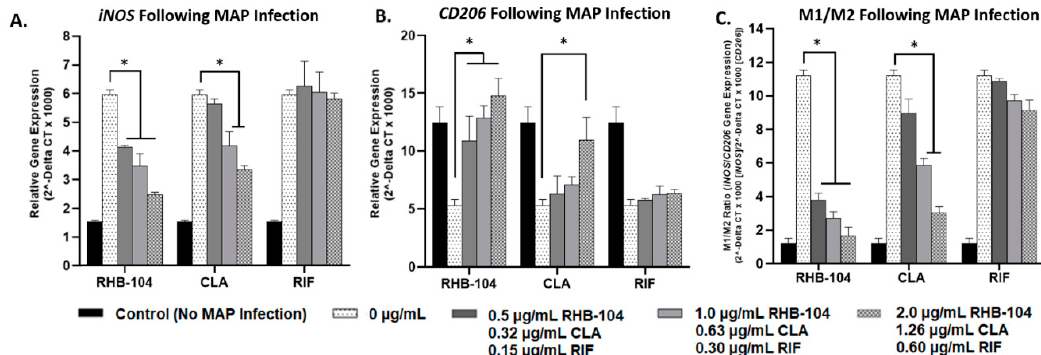
Figure 2. E ff ect of RHB-104 and its major components on M1 / M2 macrophage polarization in MAP-infected macrophages. RT-PCR was used to measure expression of ( A ) iNOS (M1), and ( B ) CD206 (M2) in MAP-infected macrophages (24 h) following dose-dependent treatment with RHB-104 (0, 0.5, 1.0, 2.0 µ g / mL), CLA (0, 0.32, 0.63, and 1.26 µ g / mL), and RIF (0, 0.15, 0.30, 0.60 µ g / mL) for 24 h. ( C ) Illustrates the calculated iNOS / CD206 (M1 / M2) ratio for all treatments. * p <